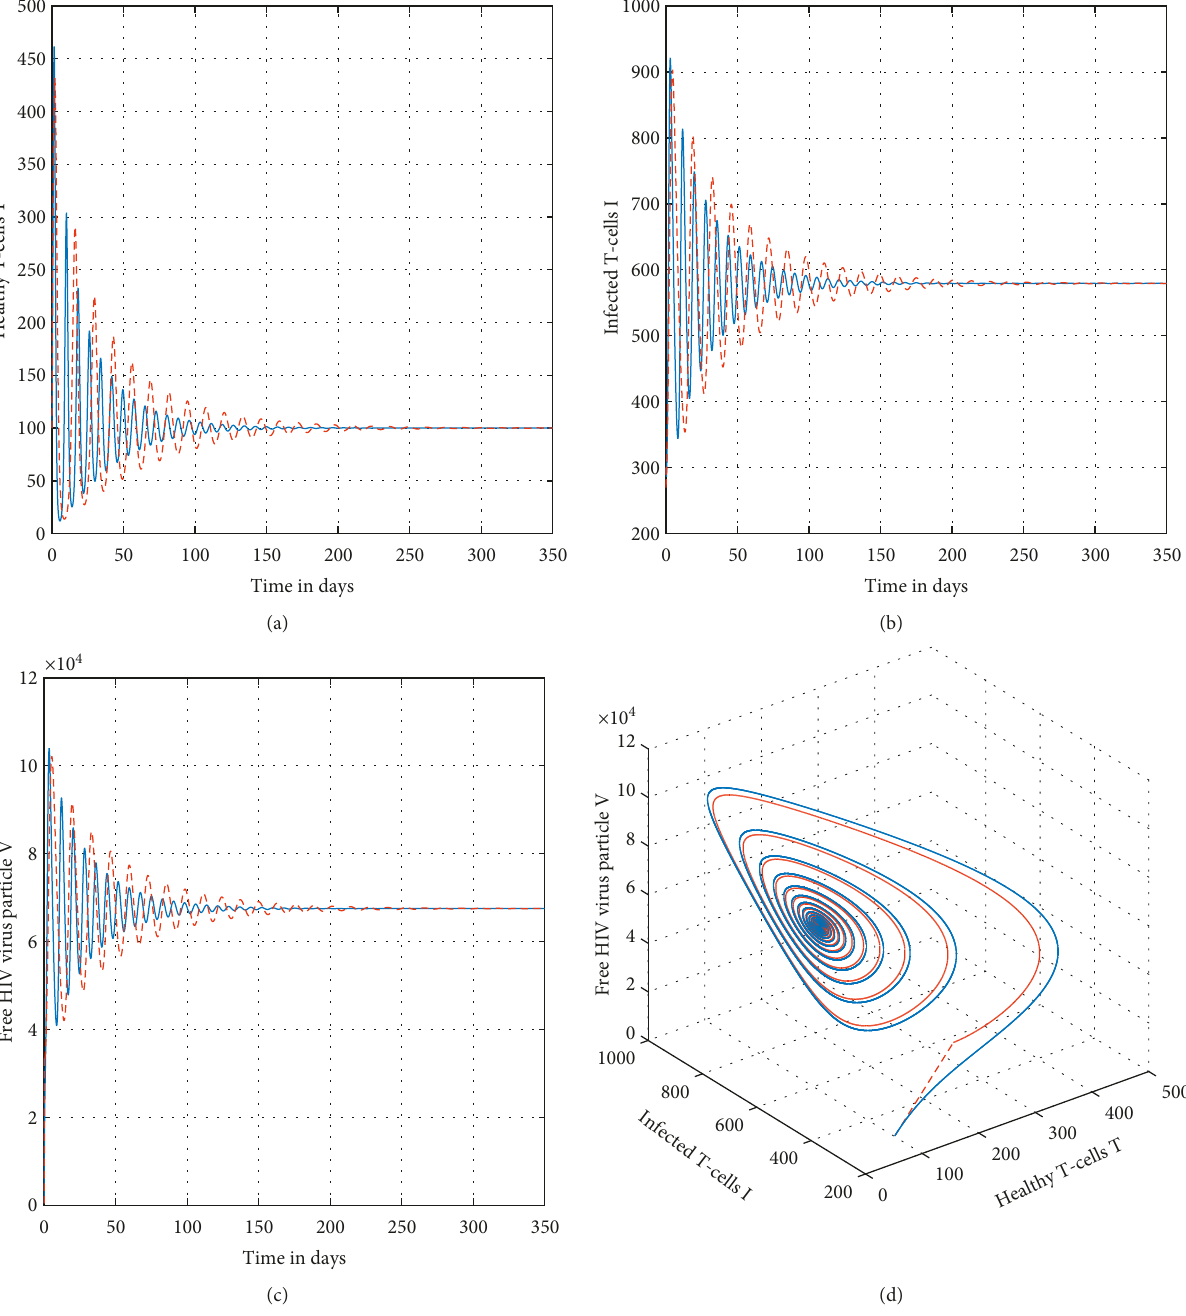
Figure 2: Graphical view analysis of the fractional model (2) of HIV by taking the index of memory ϑ � 0 .